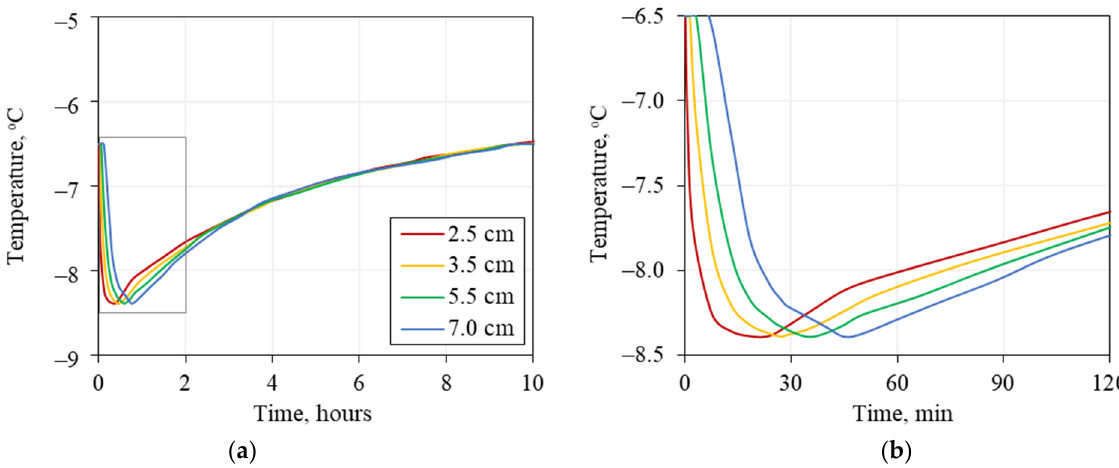
Figure 5. Time-dependent temperature variations in the hydrate-saturated frozen sample (S hin = 38%, S iin = 15%) at 2.5, 3.5, 5.5, and 7.0 cm from the contact with 1.0 N NaCl solution (t in = − 6.5 ° С , p = 0.1 MPa): ( a ) in the current experiment; ( b ) in a narrower time interval before the temperature became unique in the sample structure.